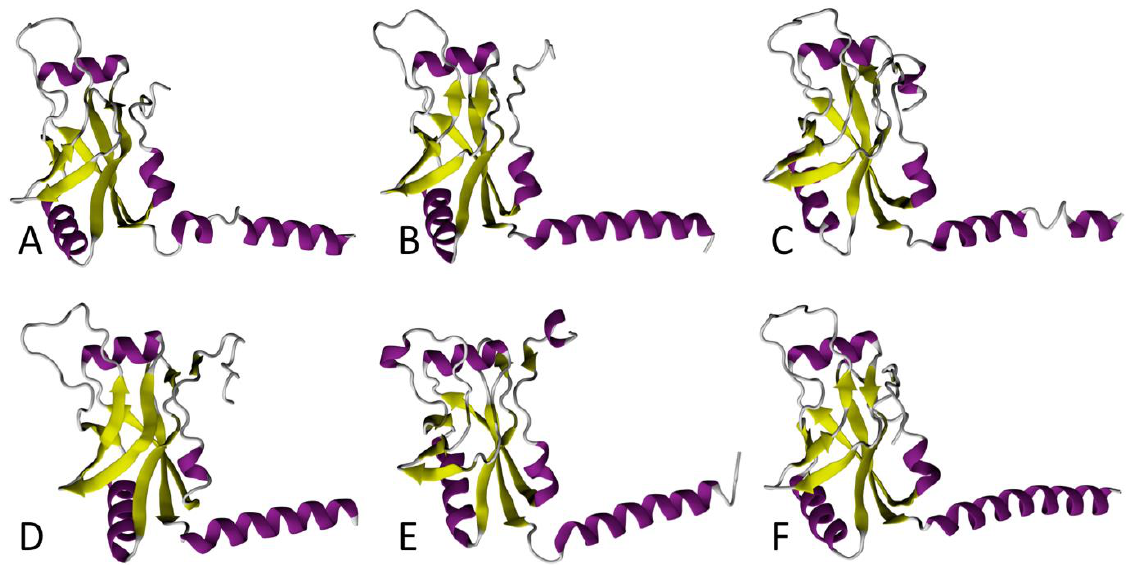
Figure 2. Comparison between 3D models of SmpB in ESKAPE bacteria . In each conformation, the tmRNA TLD contact region is on the left side, and the helix-shaped C-terminal end is shown to the right. The α-helices and β-strands are purple and yellow, respectively. These models of Enterococcus faecium ( A ), Staphylococcus aureus ( B ), Klebsiella pneumoniae ( C ), Acinetobacter baumannii ( D ), Pseudomonas aeruginosa ( E ), and Enterobacter cloacae ( F ) were all computed with the I-TASSER program using E. coli SmpB as the structural template (PDB 7ACJ).